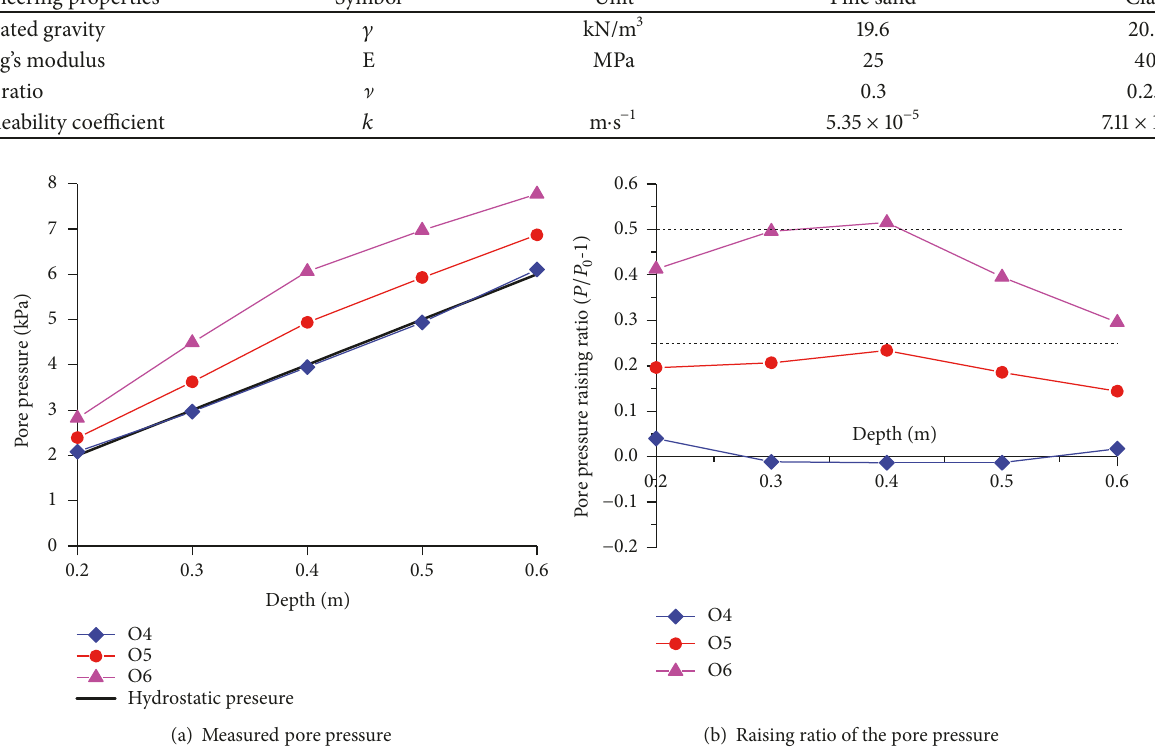
Figure 7: Pore pressure at different